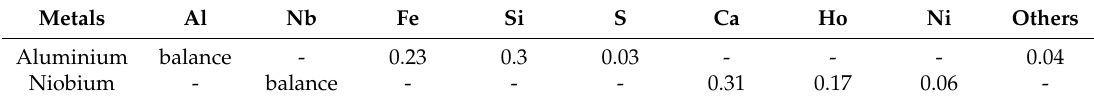
Table 1. Chemical composition (wt.%) of the metals used to prepare the alloys.